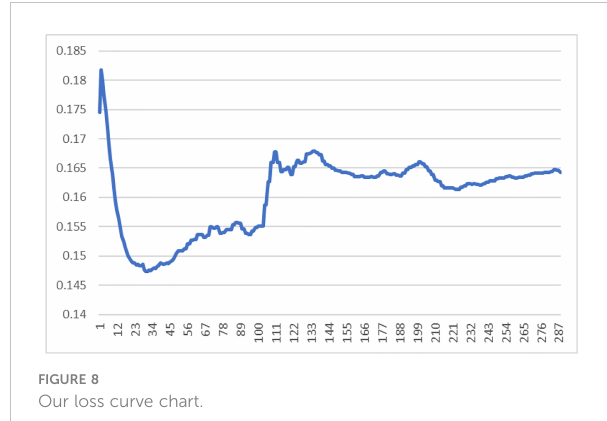
FIGURE 8 Our loss curve chart.